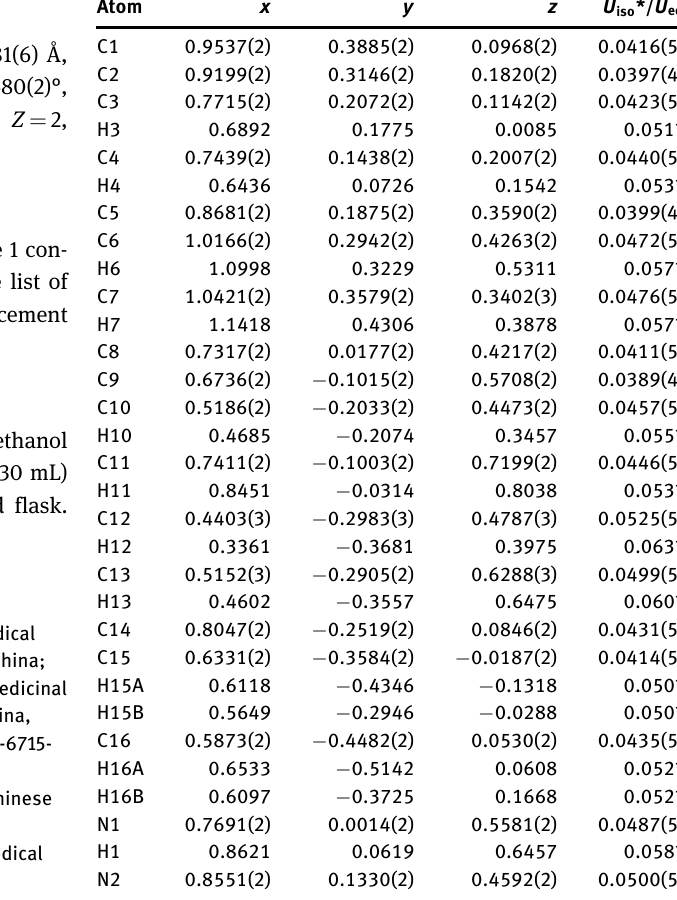
Table 2: Fractional atomic coordinates and isotropic or equivalent isotropic displacement parameters (Å 2